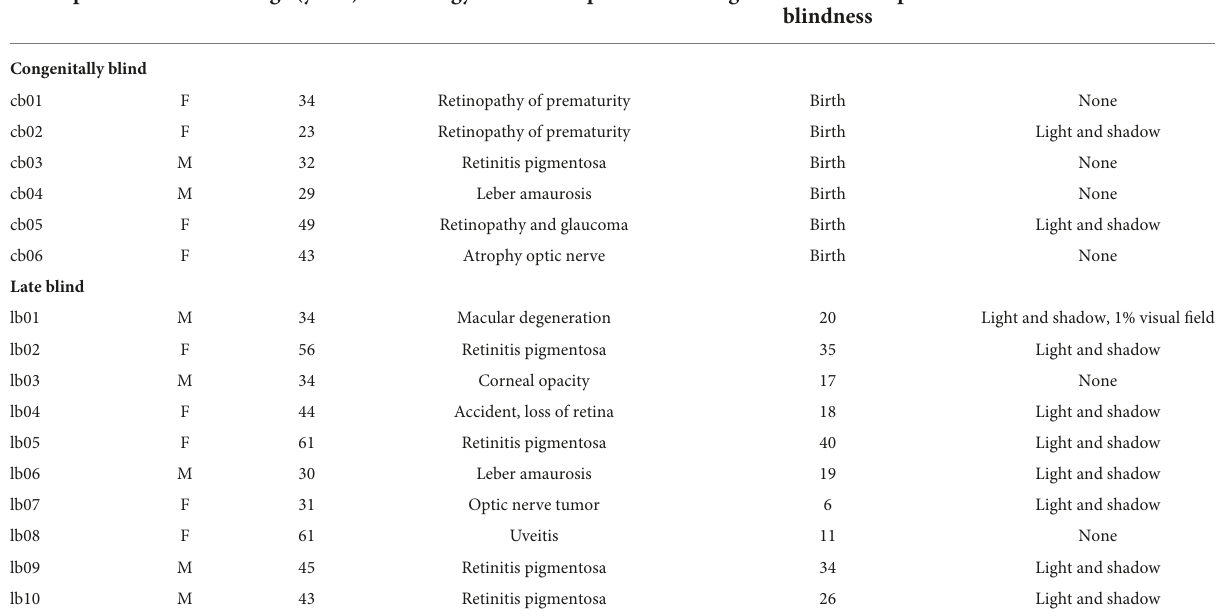
TABLE 1 Characteristics of the blind